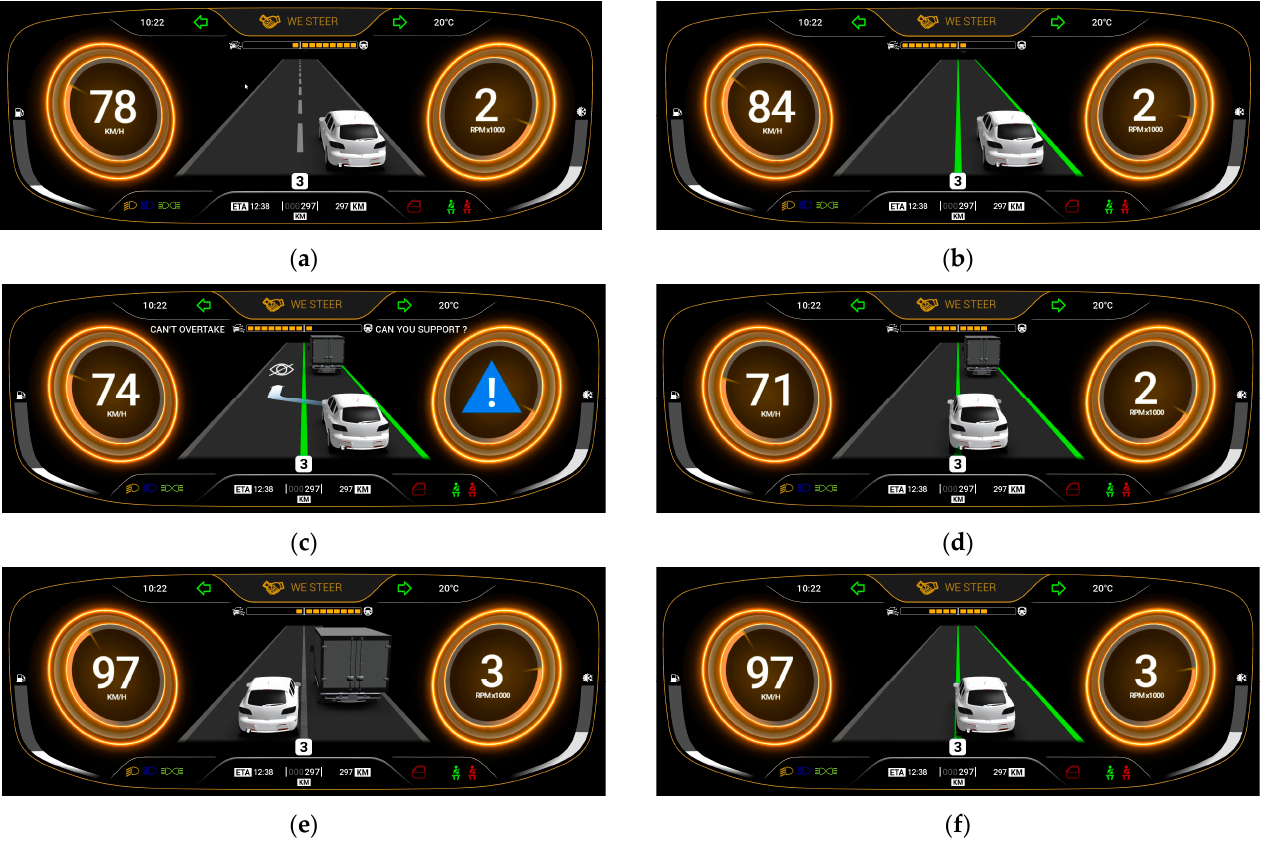
Figure 9. Sequence of overtaking using SC from the HMI view: ( a ) vehicle in manual mode, ( b ) vehicle in automated mode at maximum speed, ( c ) cooperation suggested by automation, ( d ) driver initiates lane change and transition to manual starts, ( e ) transition to manual completed to perform overtaking, ( f ) driver returns and automated mode is activated automatically.